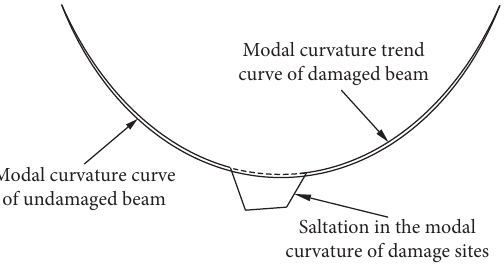
Figure 7: Change of modal curvature